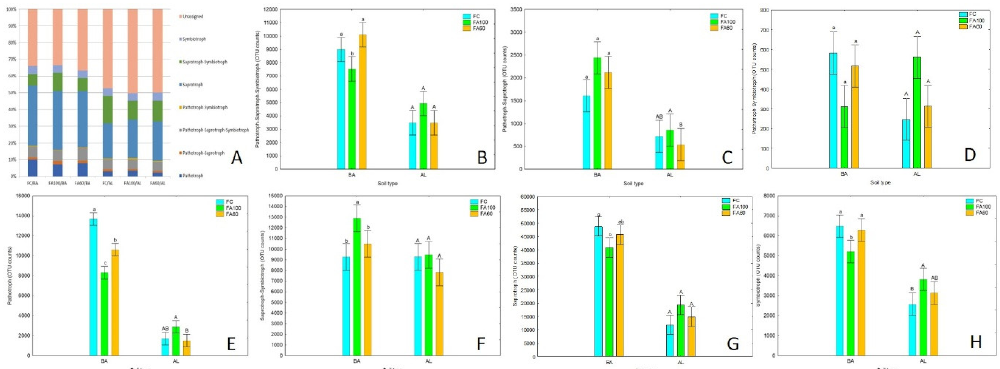
Figure 13. Relative abundance and OTUs counts for fungal functional groups (guilds) in two different soil types Brunic Arenosol and Abruptic Luvisol after biofertilizer application. ( A )—fungal functional groups in tested soils and treatments, ( B )—OTUs counts of pathotrophs-saprotrophs-symbiotrophs,